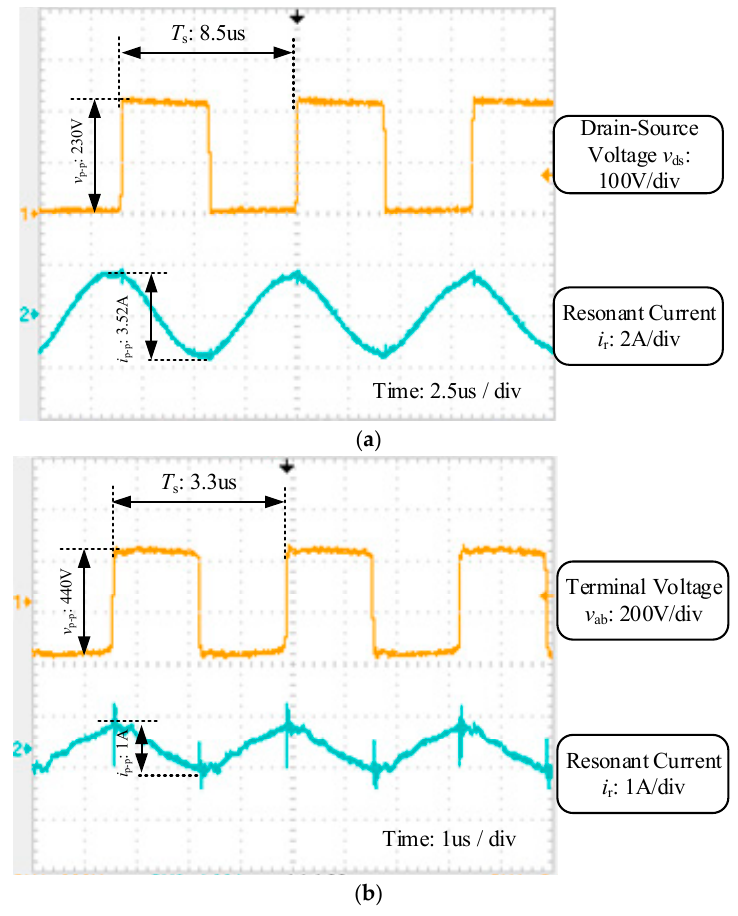
Figure 7. Waveforms of switcher voltage and current ( a ) with heavy loads and ( b ) with light loads.